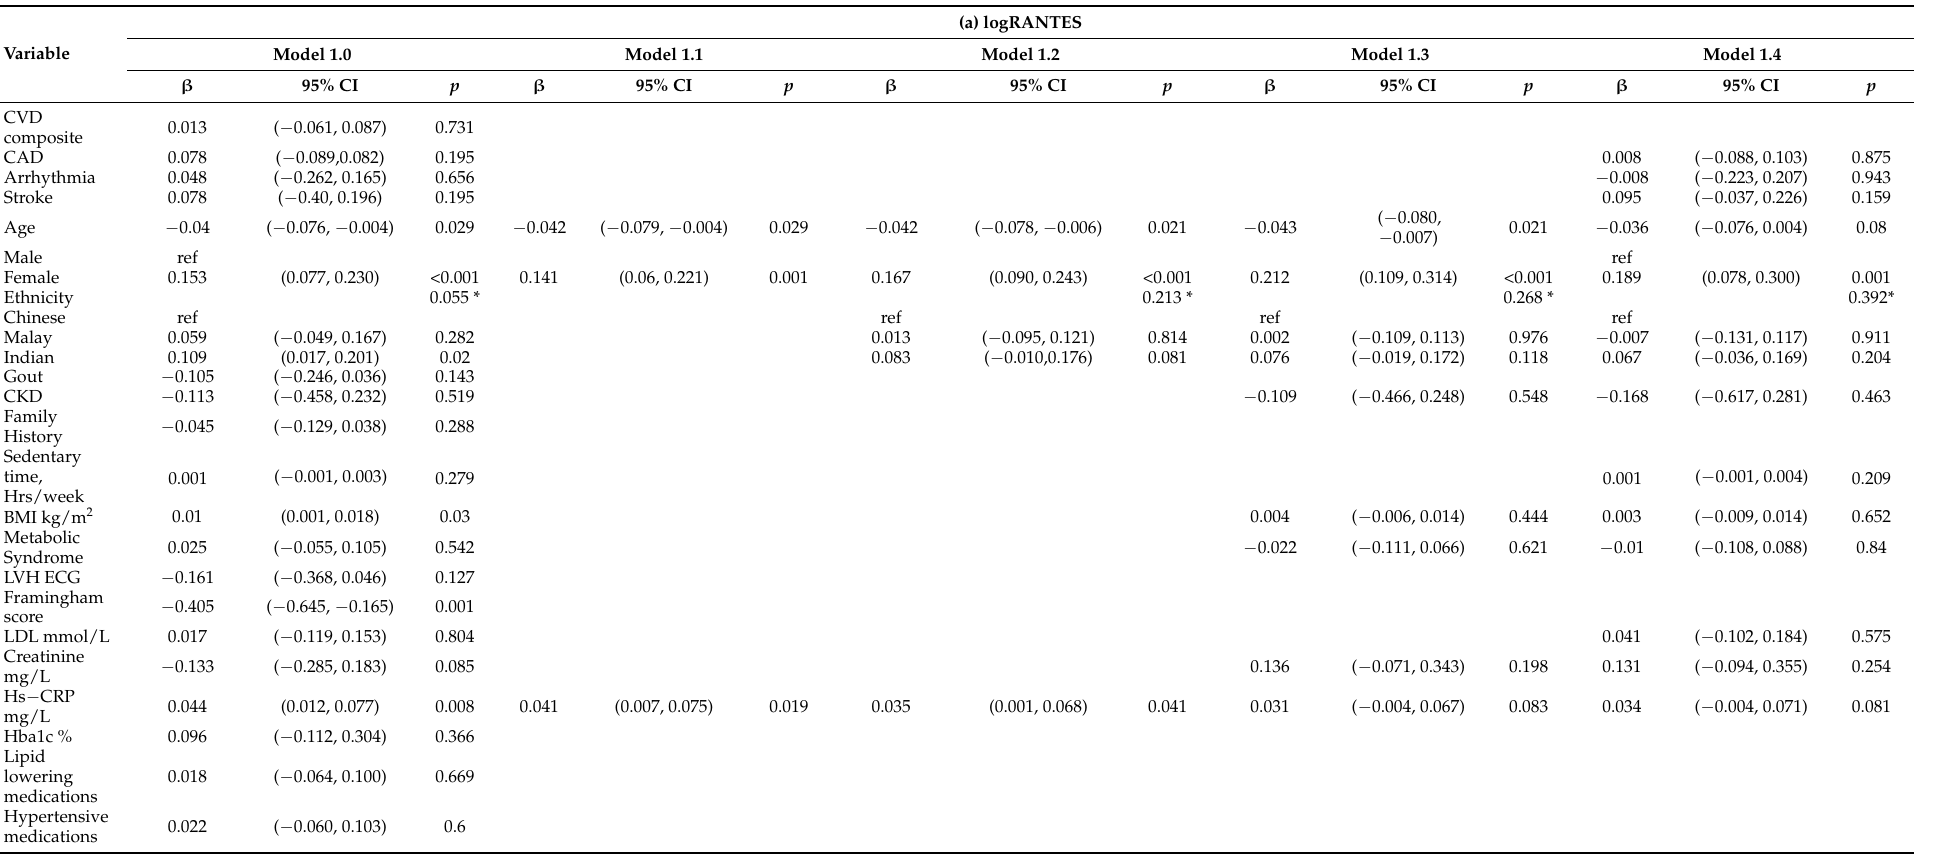
Table 2. Factors associated with the biomarkers: ( a ): LogRANTES; ( b ): Log EMMPRIN; ( c ): Log MMP-2; ( d ): Log